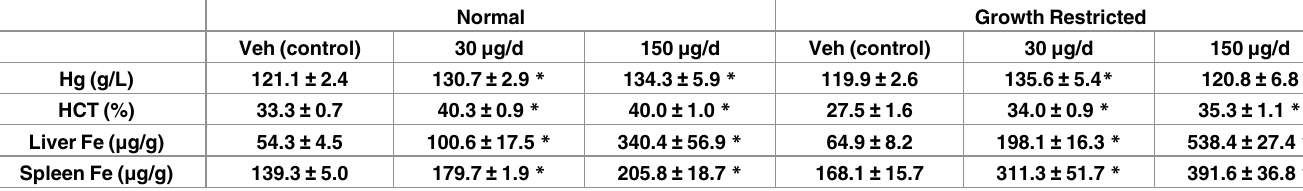
Hemoglobin, hematocrit, and tissue iron content in liver and spleen of rats at PD20. Values are presented as mean ± SEM. * p < 0.05, assessed by Student’s t-test compared to Veh